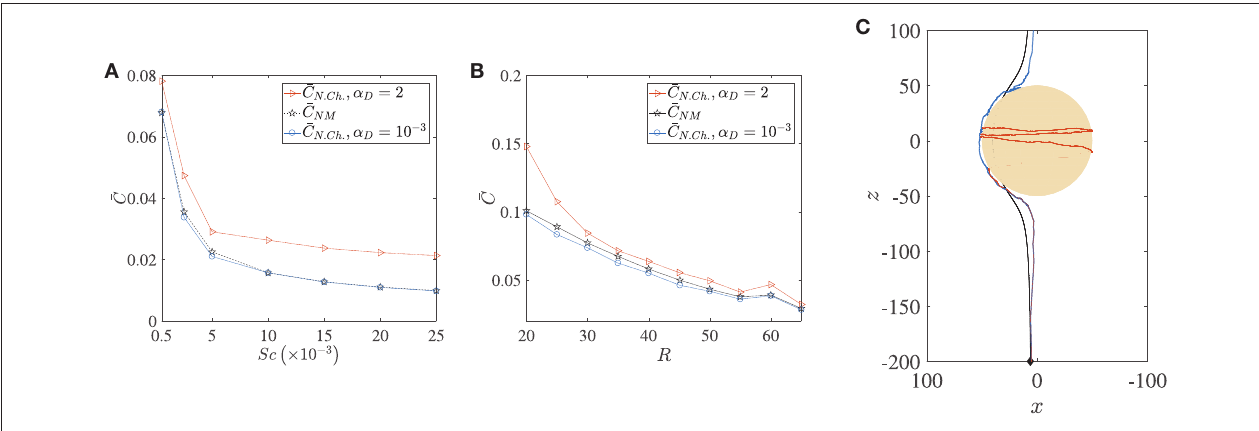
FIGURE 9 | A comparison of the average nutrient exposure, ¯ C , between motile but non-chemotactic bacteria and non-motile bacteria, as a function of (A) the nutrient diffusivity, with dimensionless aggregate radius R = 45, and (B) the (dimensionless) radius of the marine snow particle, R , with Schmidt number Sc = 25000. (C) Sample trajectories for the three cases whose nutrient exposures are plotted in (B) , R = 50, with correspondence based on line colors. The blue and brown trajectories are indistinguishable until they near the aggregate, and the latter gets trapped. Notice the “smoothness” of the non-motile trajectory (black) vs. that of the non-chemotactic trajectory of bacterium with weak hydrodynamic interaction (blue). The nutrient exposure for motile, non-chemotactic bacteria has been evaluated for both strong ( α D = 2) and weak ( α D = 10 − 3 ) hydrodynamic interactions. The other parameters are: K 1ρ = 0.0109, τ ∗ =